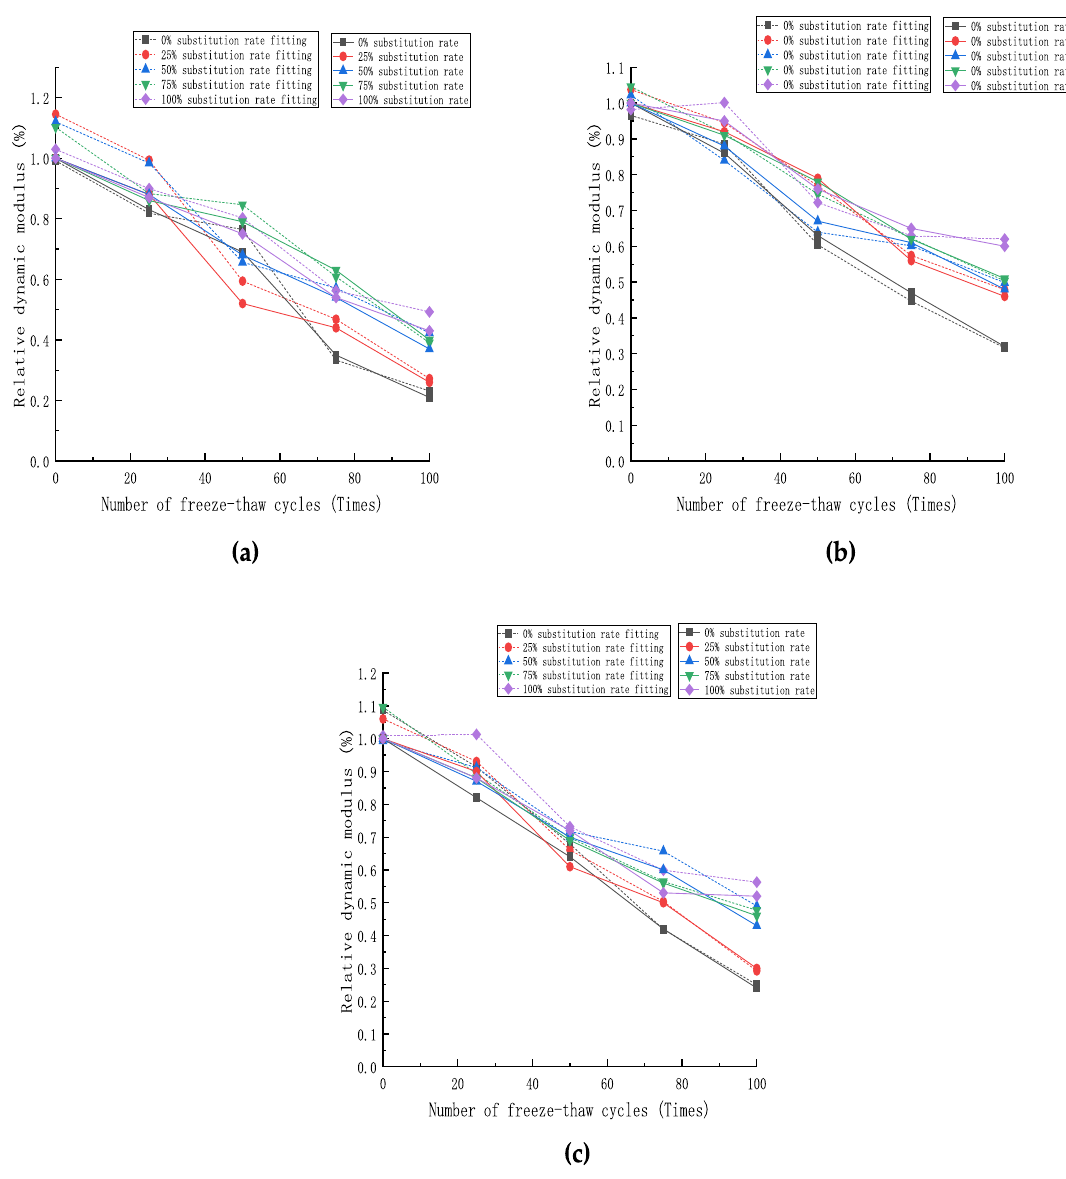
Figure 13. Relative dynamic elastic modulus fitting curve: ( a ) steel fiber content 0%; ( b ) steel fiber content 1%; ( c ) steel fiber content